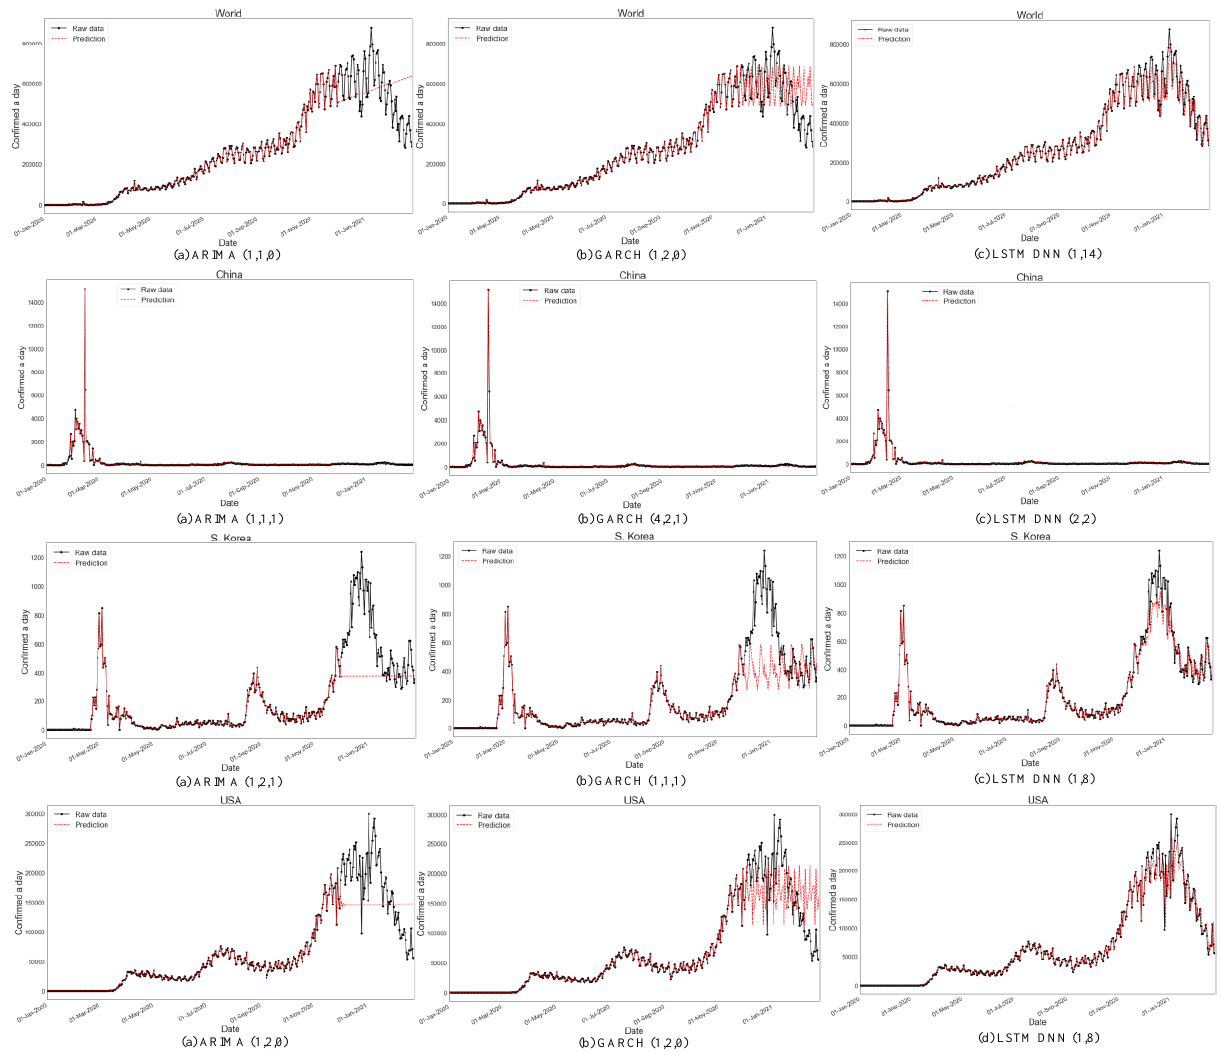
Figure 7. Raw data and 1-step ahead prediction of daily confirmed cases: World and three countries ( r = 0.8)